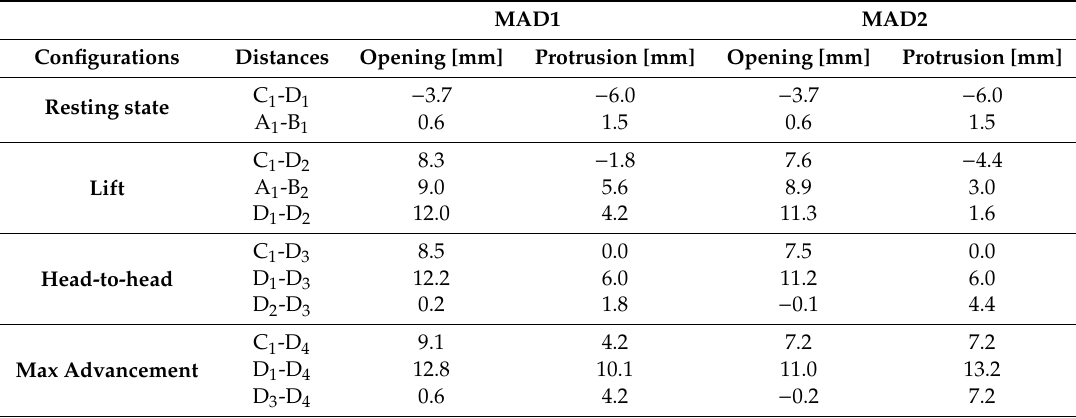
Table 4. Assessment of inter-jaws dynamics from resting state to mandibular maximum advancement. Distances are evaluated concerning the resting state (configuration 1) and concerning the previous configuration (configuration i-1).